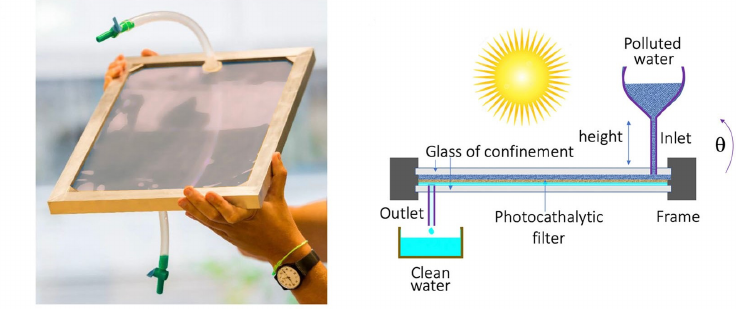
Figure 28. Picture and illustration of a photocatalytic water filter. (Reprinted/adapted with permis- sion from Ref.